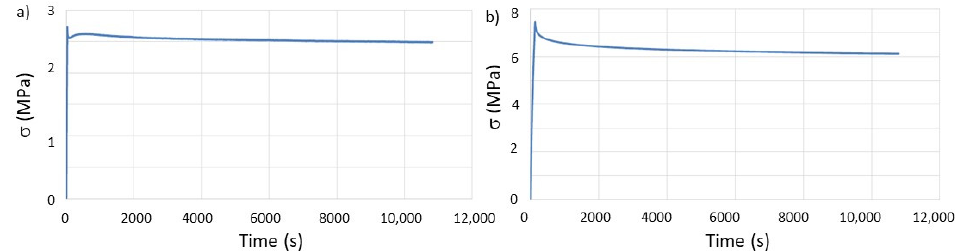
Figure 5. Evaluation of stress relaxation behavior, over time, of the as-printed specimens: ( a ) T and